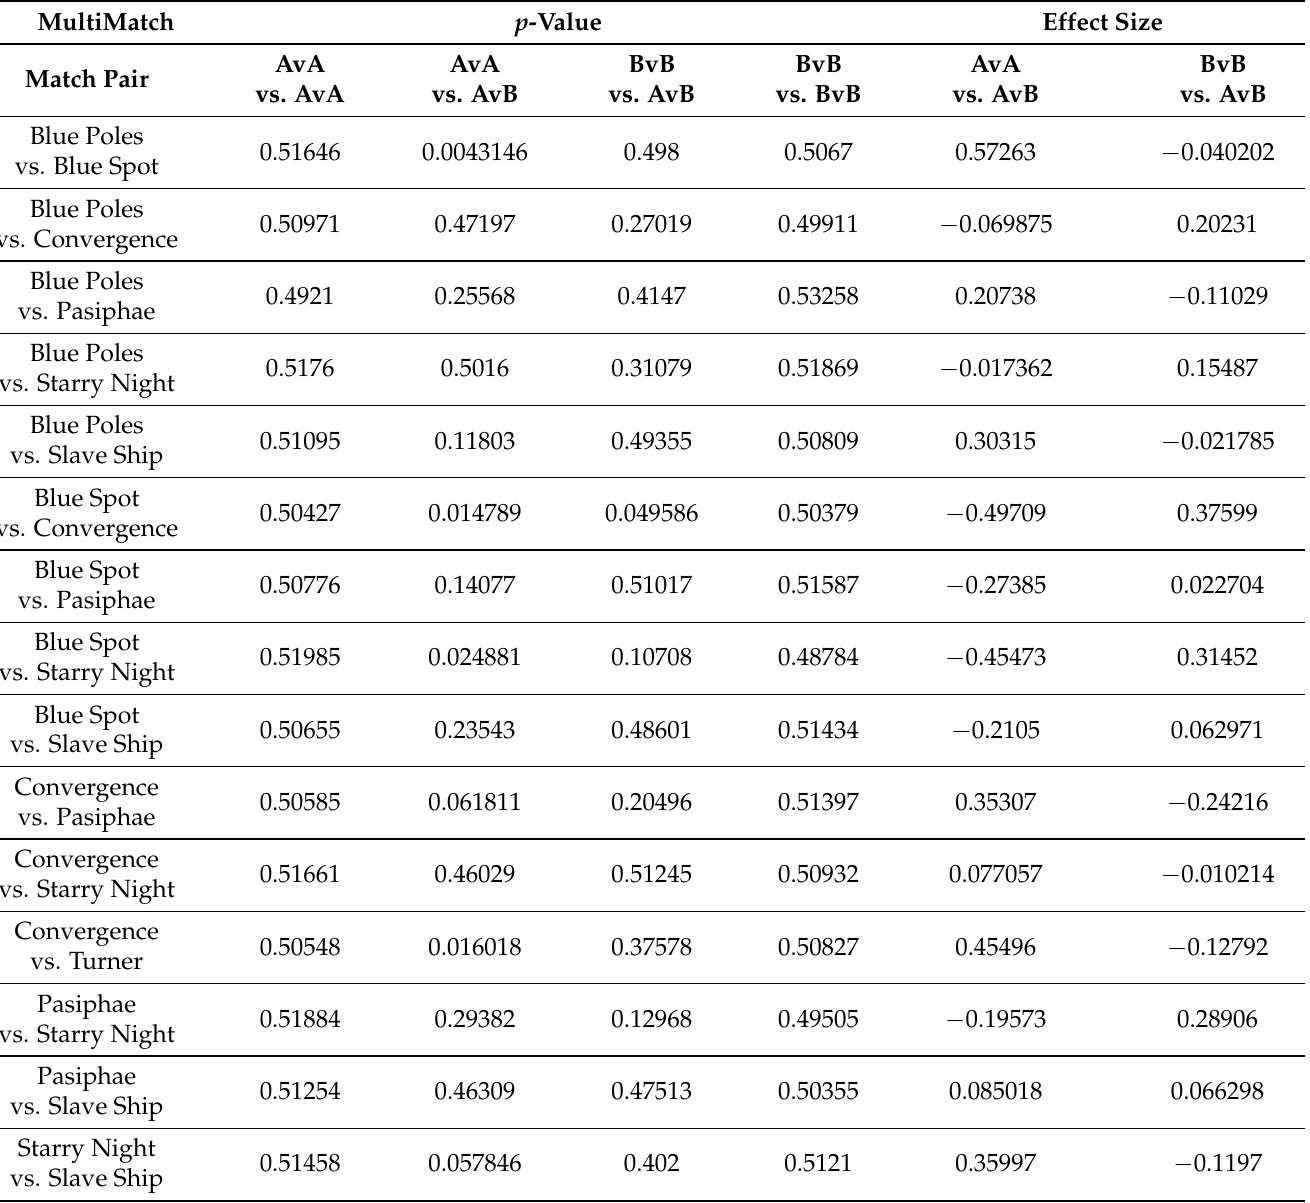
Table A3. MultiMatch vector results. Match pair (e.g., Blue Poles vs. Blue Spot), where AvA, AvB, and BvB represents a match score based on a comparison of the one member of the pair with itself, or the first member of the pair ( A ) (e.g., Blue Poles) and the second member, B (e.g., Blue Spot). The effect size for (AvA vs. AvA) and (BvB vs. BvB) in all cases was